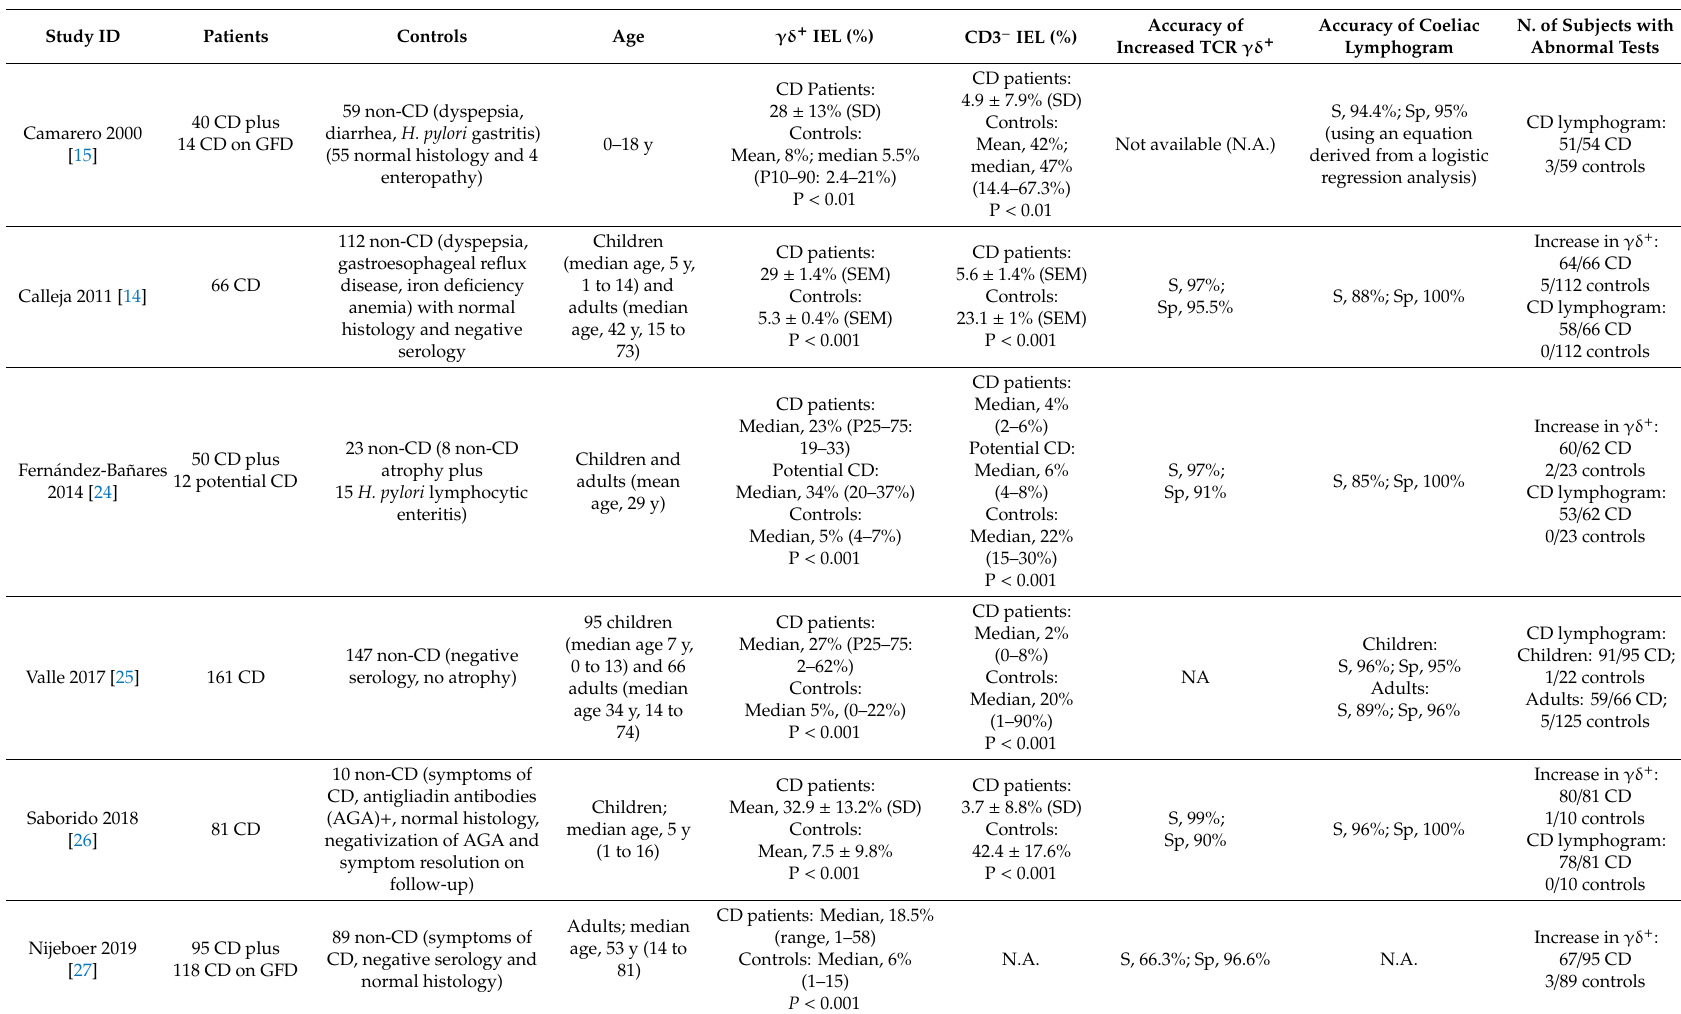
Table 1. Summary of selected